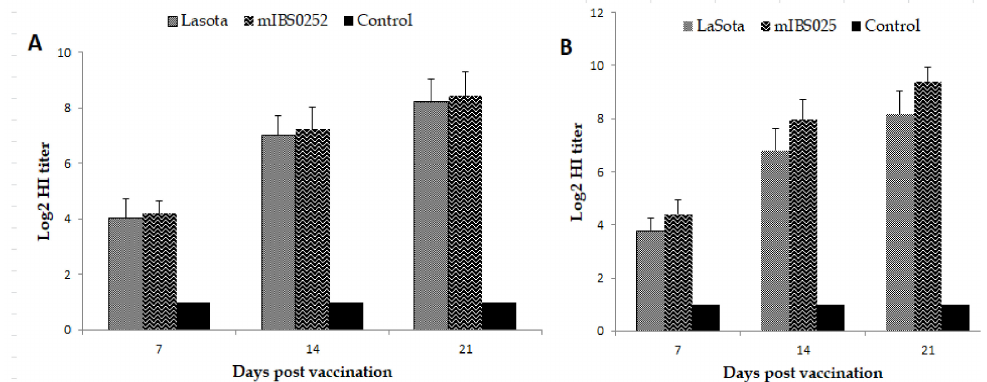
Figure 3. Post vaccinal HI antibody titers in 1-day old SPF chicks immunized with LaSota and mIBS025. Serum samples collected from vaccinated chicks (10 per group) at indicated time points post vaccination were subjected to HI test using ( A ) Lasota (genotype II NDV).and ( B ) wild type IBS025 / 13 (genotype VII NDV) as HA antigens. Results obtained were expressed as geometric mean titers (Log2) ± SD.